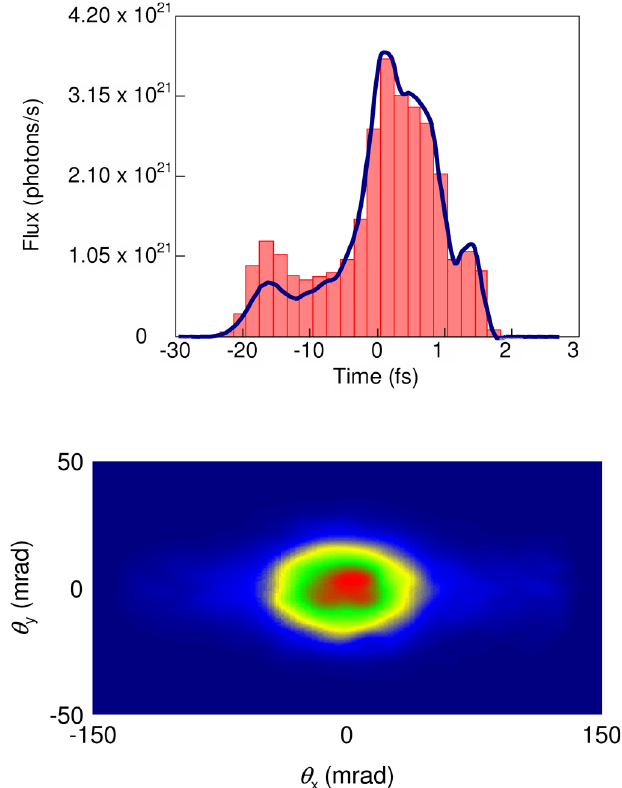
FIG. 5. (Color) Top: temporal x-ray pulse shape, as simulated by the three-dimensional time and frequency domain Compton code, using the three-dimensional PIC code-generated electron beam phase space as an input. The temporal x-ray pulse (blue line) is superimposed on the temporal electron distribution to show the close correlation. Bottom: x-ray angular energy distri- bution.